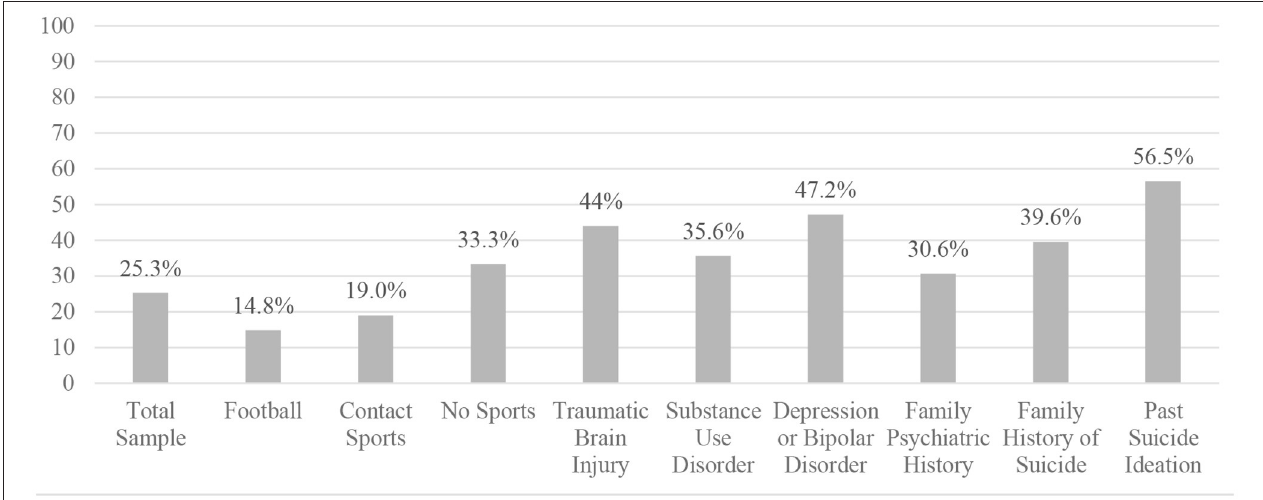
FIGURE 2 | Proportions with a history of suicide attempts stratified by